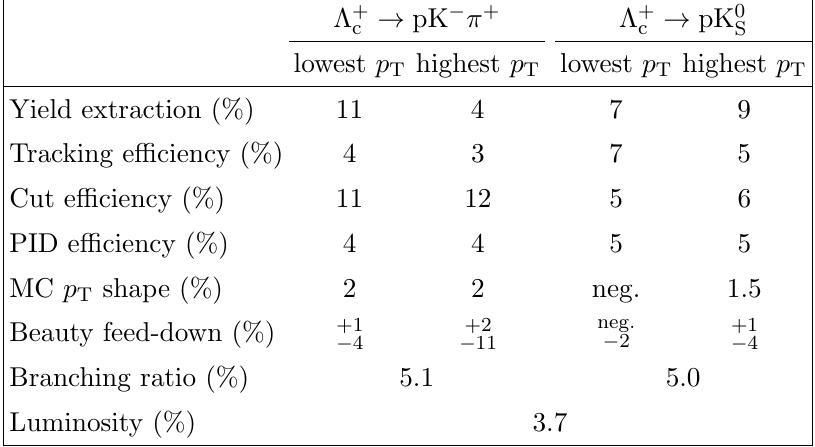
Table 2 . Summary of relative systematic uncertainties for the lowest and highest p T intervals con- sidered in the analysis, for the two (cid:3) c hadronic decay modes in pp collisions. When the uncertainty was found to be < 1%, it was considered negligible (\neg." in the table).